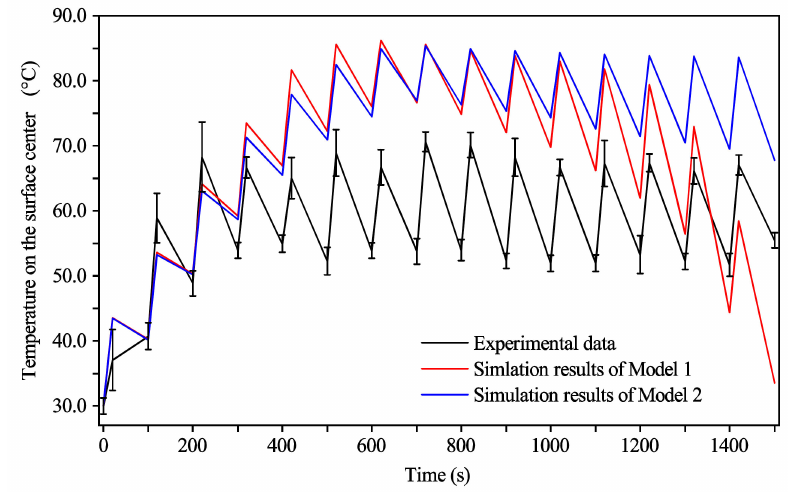
Figure 6. Temperature on the center of the top